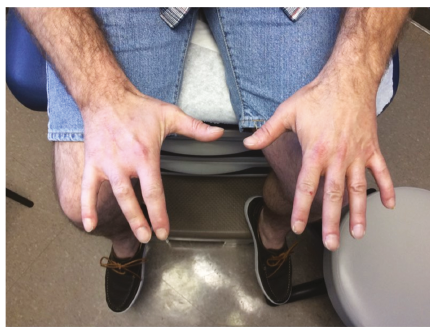
Figure 10: Image of patient ’ s hand at one-year follow-up visit.